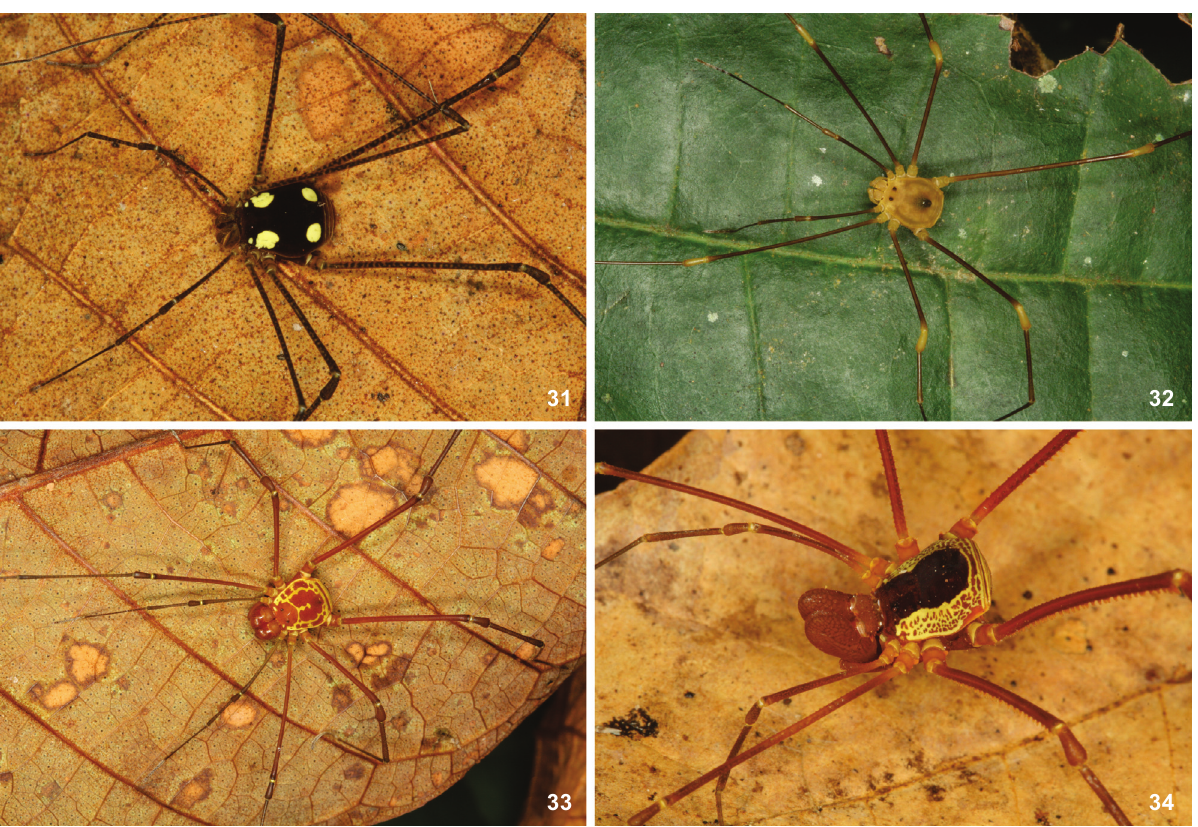
Coloration. Dorsal scutum and coxae dark brown. Che- licera brown. Legs and pedipalps light yellowish brown. Yel- low patch U-shaped covering irregularly anterior margin, lateral surface of prosoma and areas, reaching the posterior margin and forming a narrow stripe behind spine. Dorsal scutum dark brown with small irregular yellow patches. Free tergites I-III with one stripe